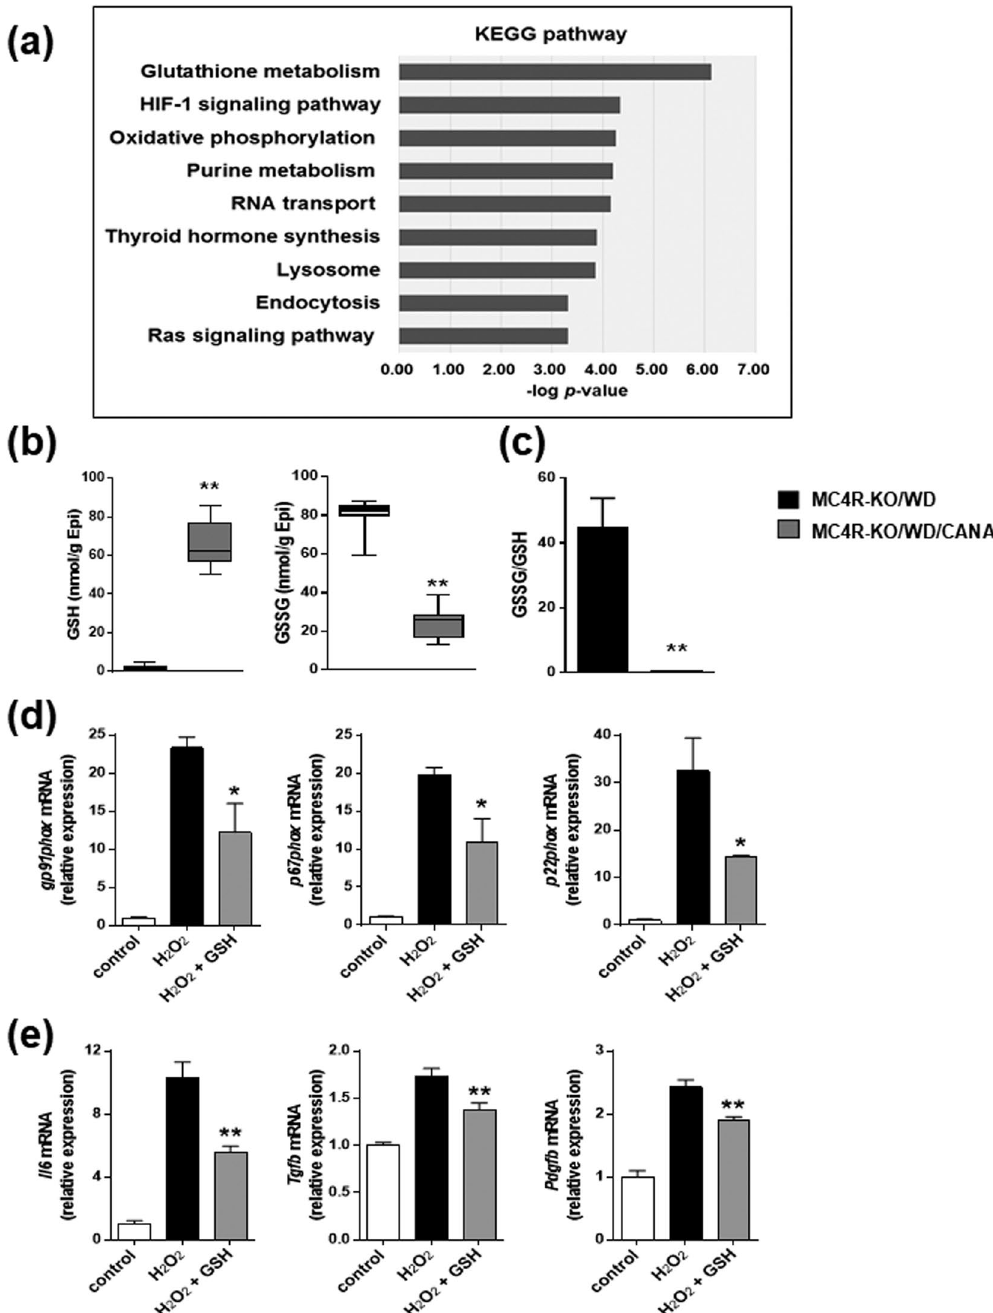
Figure 4. CANA increases GSH content in epididymal fat of WD-fed MC4R-KO mice. ( a ) The pathways enriched among the upregulated ( > 2.0-fold) metabolites in the epididymal fat of MC4R-KO mice treated with CANA for 8 weeks compared to those without treatment. The results are expressed as − log ( p value). Metabolite concentrations of ( b ) GSH and GSSG, and ( c ) GSSG/GSH ratio of the epididymal fat. Data are mean ± SEM, * p < 0.05, ** p < 0.01 vs MC4R-KO/WD; Student’s t test. n = 7. ( d ) Expression levels of NADPH oxidase complex genes in differentiated 3T3-L1 adipocytes treated with 200 µ M H 2 O 2 for 18 h after pretreatment with or without 1 mM GSH for 1 h. ( e ) Expression levels of inflammation-related genes in RAW 264.7 cells treated with 200 µ M H 2 O 2 for 18 h after pretreatment with or without 1 mM GSH for 1 h. * p < 0.05, ** p < 0.01 vs H 2 O 2 . Statistical analyses were performed using Mann-Whitney ( b ), non-paired Student’s t ( c ), or one-way ANOVA ( d and e ) followed by Bonferroni post hoc test; H 2 O 2 and H 2 O 2 + GSH was pre-selected as a subset of means to compare. n =